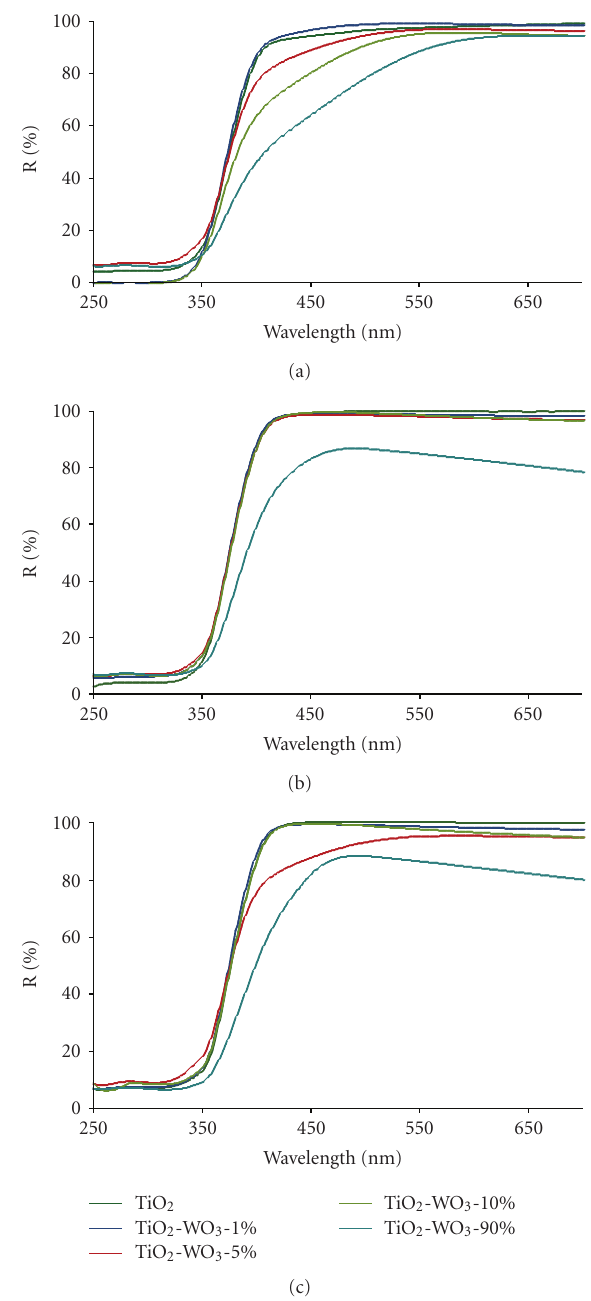
Figure 1: Di ff use reflectance spectra of TiO 2 and WO 3 -TiO 2 photocatalysts, (a) as received, (b) calcined at 400 ◦ C, and (c) calcined at 600 ◦